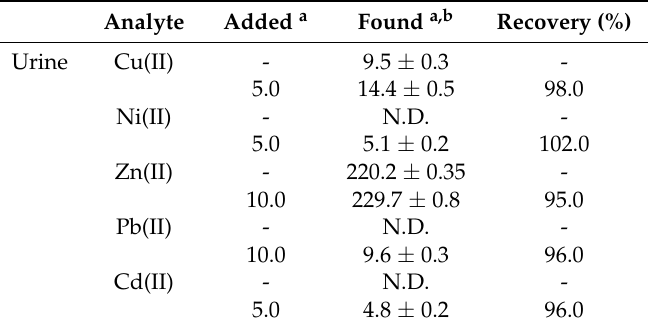
Table 4. Analytical results of essential and toxic metal determination in urine samples using the FI-FDSE-FAAS method.